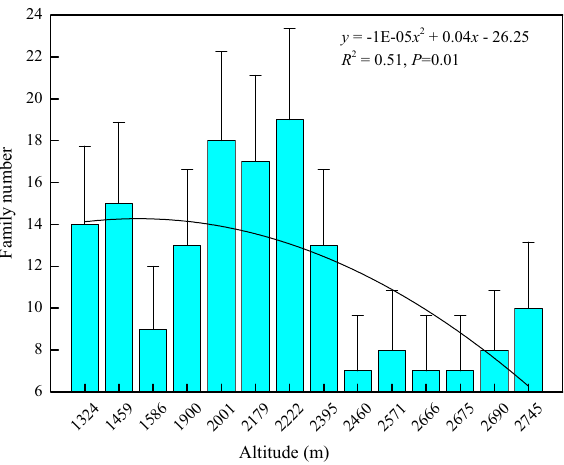
Figure 2. Variation in herb family number with an altitudinal gradient. The family number of the herb community was counted at each elevation, and curve fittings were conducted on the variation in family number with an altitudinal gradient. Data for the family number were obtained from 80 sub-quadrats at each